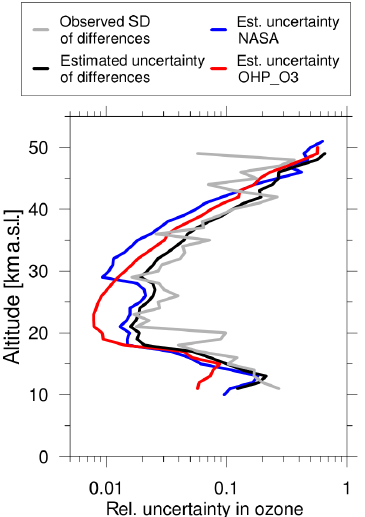
Figure 10. Vertical profiles of relative ozone uncertainties. Red indicates estimated by the LiO 3 S retrieval. Blue indicates esti- mated by the NASA STROZ retrieval. Black indicates estimated for the relative ozone difference between NASA STROZ and LiO 3 S (O 3 ( NASA )/ O 3 ( OHP ) − 1). Grey indicates observed standard devi- ation for the relative ozone differences between NASA STROZ and LiO 3 S during